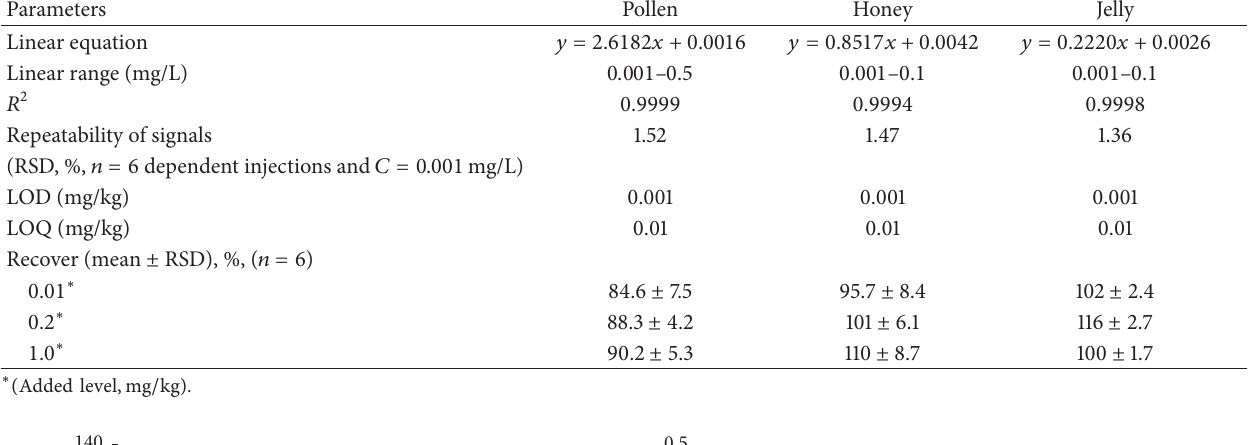
Table 3: Partial validation parameters for carbendazim added in different blank samples.